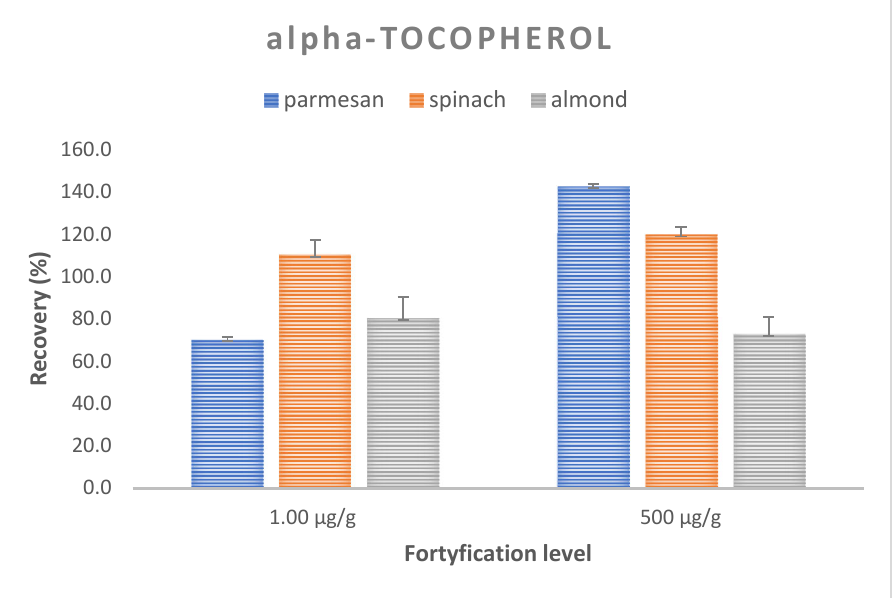
Figure 4. Recovery and CV values for vitamin E at two spiking levels for a matrix of Parmesan, spinach, and almonds.